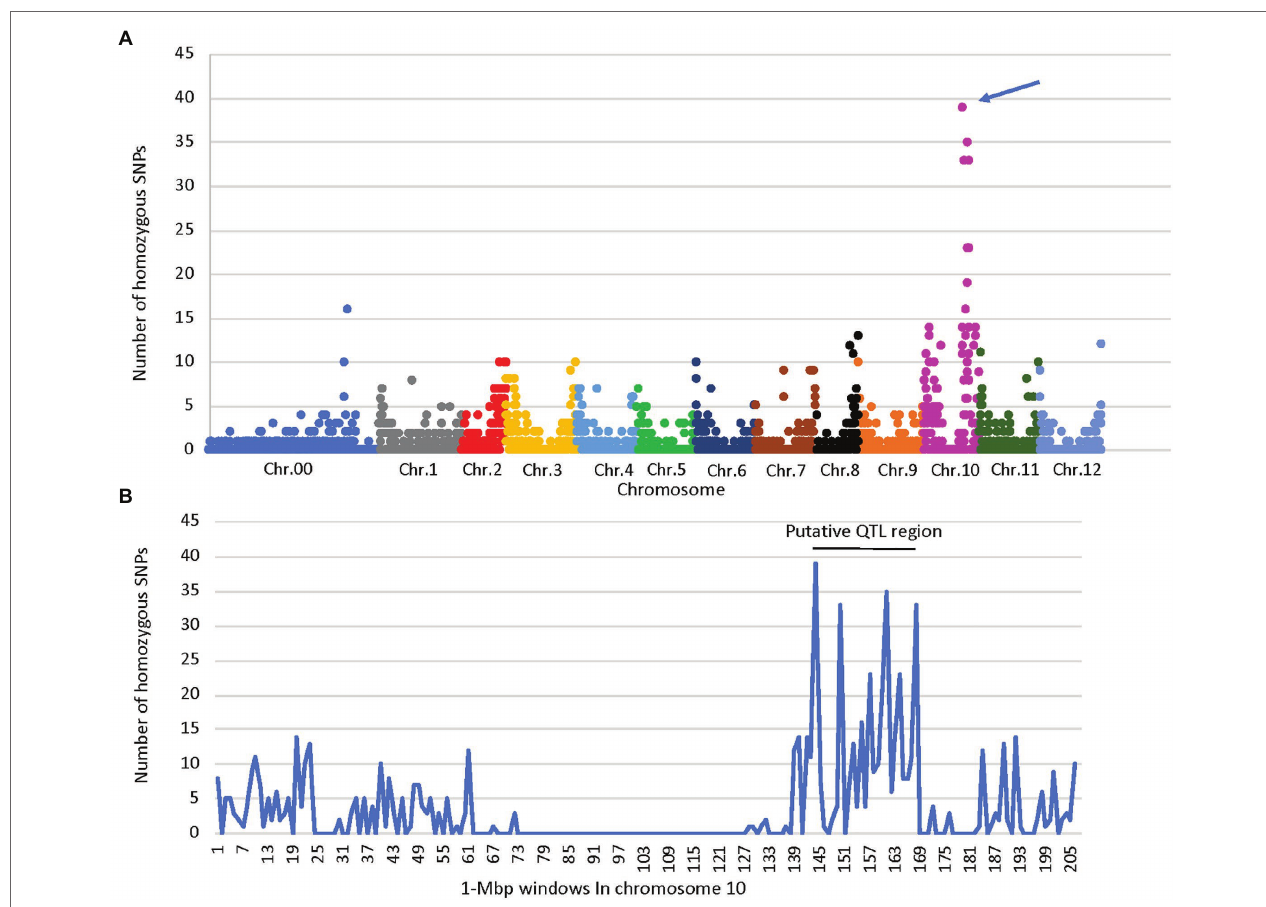
FIGURE 2 | Distribution of homozygous SNPs identified by RNAseq of the elongated- and round-fruited bulks. (A) Distribution of SNPs on each chromosome in 1 Mbp windows, indicating a QTL peak marked by an arrow on chromosome 10. (B) Distribution of SNPs on chromosome 10 in 1 Mbp windows, indicating a putative QTL region at 142–169 Mbp. Chr.00 – SNPs that were not assigned to